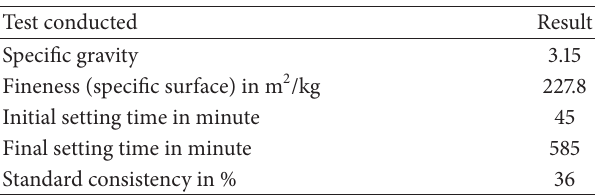
Table 1: Properties of cement.